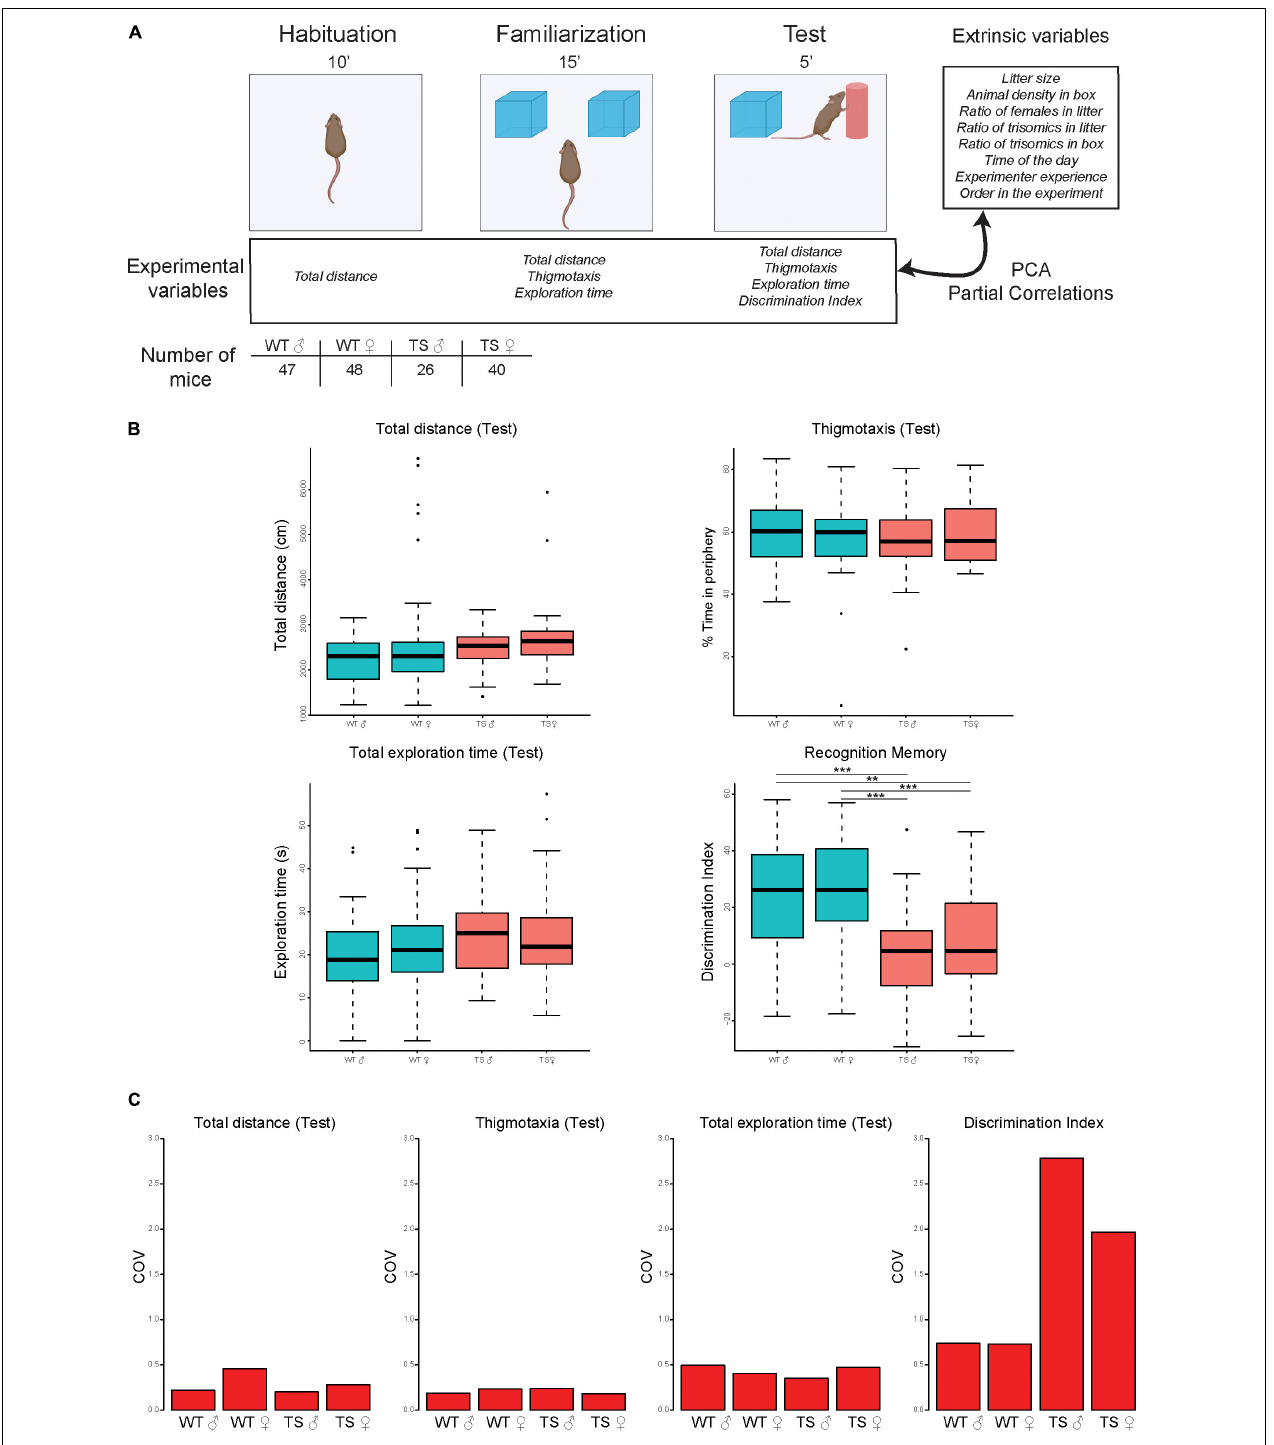
FIGURE 1 | Novel object recognition performance in the test session in male and female wild-type and Ts65Dn mice. (A) Experimental schedule showing the different phases of the NOR [habituation (10 min); familiarization (15 min), and test (5 min)], indicating the experimental variables and extrinsic factors recorded (see section “Materials and methods”). The number of mice used in the experiment is depicted. WT, wild type; TS, Ts65Dn. (B) Box plots depicting the experimental variables (total distance traveled, percentage of time in the periphery, exploration time, and discrimination index) recorded in the test session for WT and TS mice. ** p < 0.01; *** p < 0.001. (C) Coefficient of variation (COV) of the total distance traveled, thigmotaxis (percentage of time in the periphery), exploration time, and discrimination index across all groups of mice in the test session. WT, wild type male and female; TS, Ts65Dn male and female.